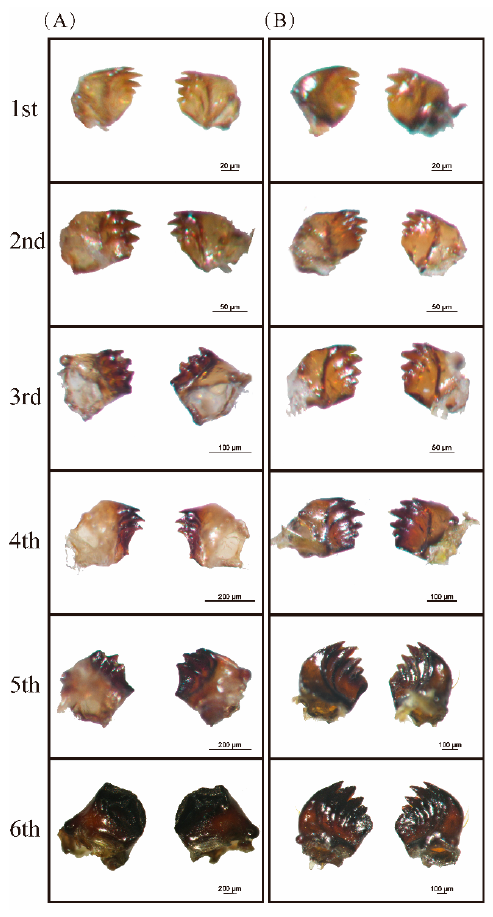
Figure 2. Morphology of larval mandibles of two armyworm species. ( A ) 1st–6th instar oriental armyworm. ( B ) 1st–6th instar fall armyworm. Larval mandibles were dissected from mouthparts and photographed.